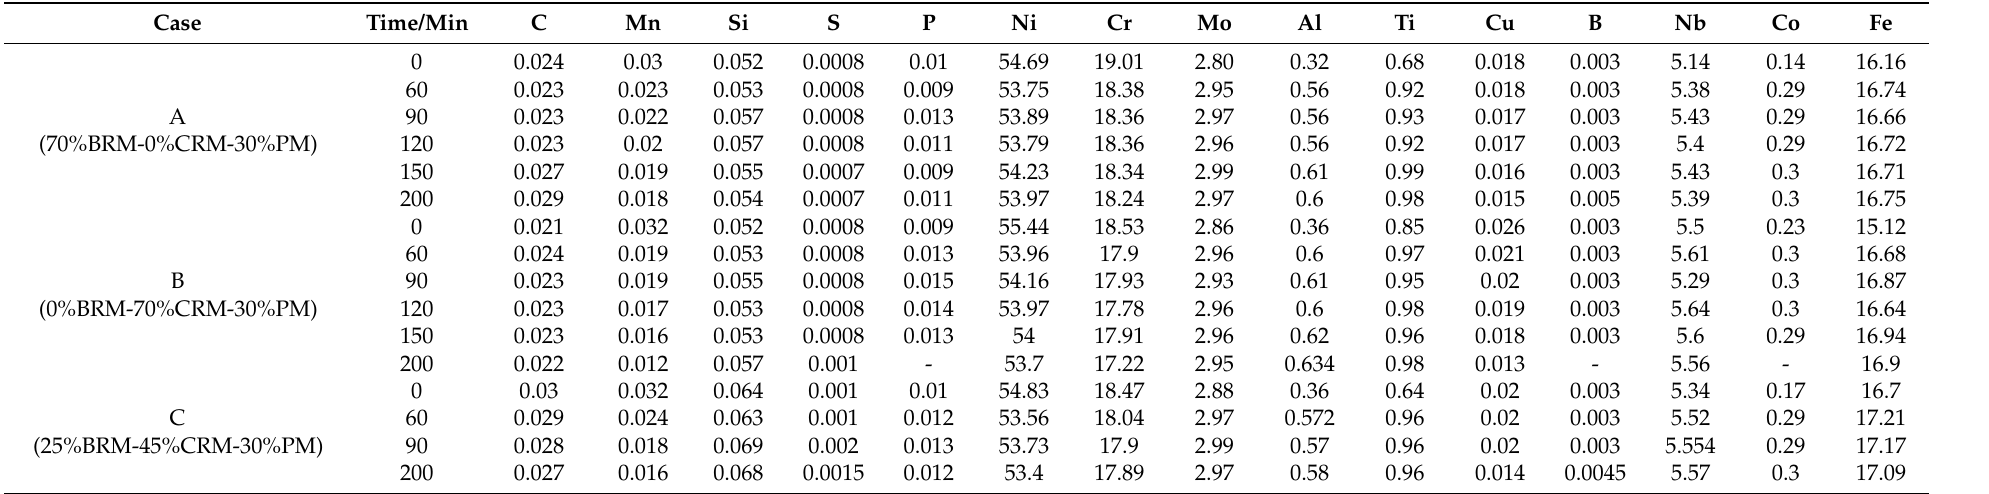
Table 3. Chemical composition of different cases during the smelting